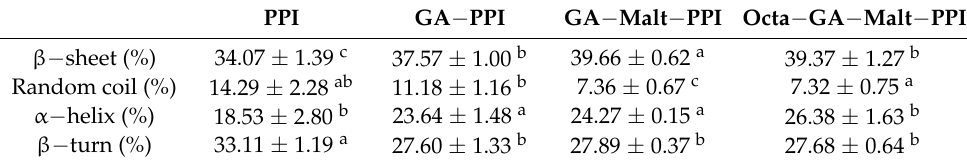
Table 3. FTIR spectra of PPI, GA − PPI, GA − Malt − PPI, and Octa − GA − Malt − PPI. PPI GA −